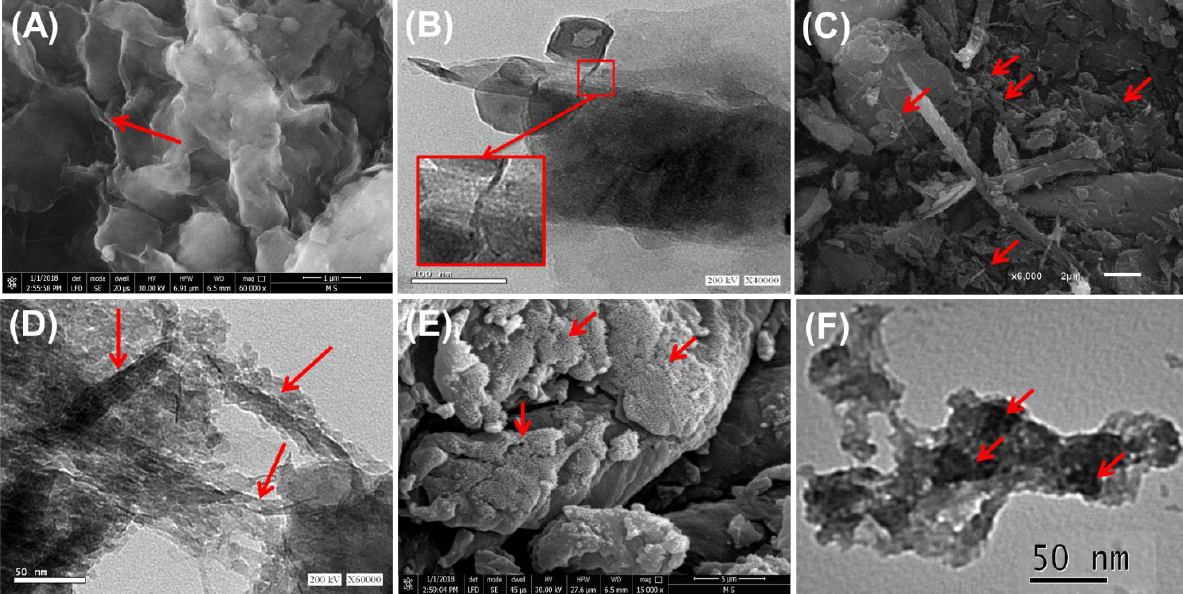
Figure 2. SEM image of raw bentonite (BE) (red arrows refer to the cornflakes structure) ( A ), HRTEM image of bentonite ( B ), SEM image of PN/BE composite ( C ) HRTEM image of PN/BE composite (red arrows refer to the polyaniline tubes) ( D ), SEM of G.Zn@PN/BE green composite (red arrows refer to the green ZnO particles) ( E ), and HRTEM image of G.Zn@PN/BE green composite (red arrows refer to the green ZnO particles) ( F ).